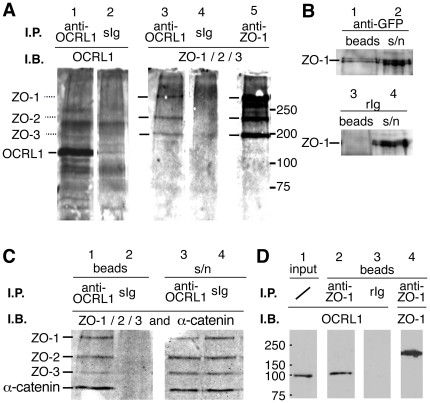
OCRL1 interacts with ZO-1, ZO-2, ZO-3 and α-catenin in polarized epithelial cells.(A) OCRL1 forms complexes with junctional proteins in MDCK cells. OCRL1 antibodies (lanes 1 and 3) were used for immunoprecipitation in parallel with respective controls – sheep immunoglobulin (sIg, lanes 2 and 4) and anti-ZO-1 (lane 5) from pre-cleared MDCK cell lysates. Precipitated proteins were run on SDS-PAGE gels, and probed with antibodies to OCRL1 (lanes 1 and 2) or with a mixture of non-cross-reacting antibodies to ZO-1, ZO-2 and ZO-3 (lanes 3, 4 and 5). Molecular weight markers are indicated from 75 to 200 kD. (B) GFP-tagged OCRL1 forms complexes with a significant proportion of ZO-1. GFP was precipitated from Caco-2 cells that had been transfected with GFP-OCRL1, and immunoblotted for ZO-1, as in A. Rabbit immunoglobulin (rIg) was used as control. (C) OCRL1 forms complexes with both tight and adherens junction proteins in MDCK cells. Antibodies to OCRL1 (lanes 1 & 3) were used for immunoprecipitation in parallel with control sheep Ig (lanes 2 & 4) from pre-cleared MDCK cell lysates. Precipitated proteins (lanes 1 & 2) and supernatants (lanes 3 & 4) were run on SDS-PAGE gels and probed with a mixture of non-cross-reacting antibodies to ZO-1, ZO-2, ZO-3 and α-catenin. In this experiment, specific precipitation of OCRL1 was highly efficient, with almost complete deletion of detectable OCRL1 from the supernatant (data not shown). (D) ZO-1 complexes in MDCK cells contain OCRL1. Antibodies to ZO-1 (lanes 2 and 4) were used for immunoprecipitation in parallel with control rabbit Ig (lane 3) from pre-cleared MDCK cell lysates (lane 1). Precipitated proteins (lanes 2 to 4) and input (lane 1, equivalent to 5% of what was added to the beads) were run on SDS-PAGE gels and probed with antibody to OCRL1 (lanes 1 to 3) or to ZO-1 (lane 4). In this experiment, α-catenin was also readily detected in anti-ZO-1 complexes (data not shown).